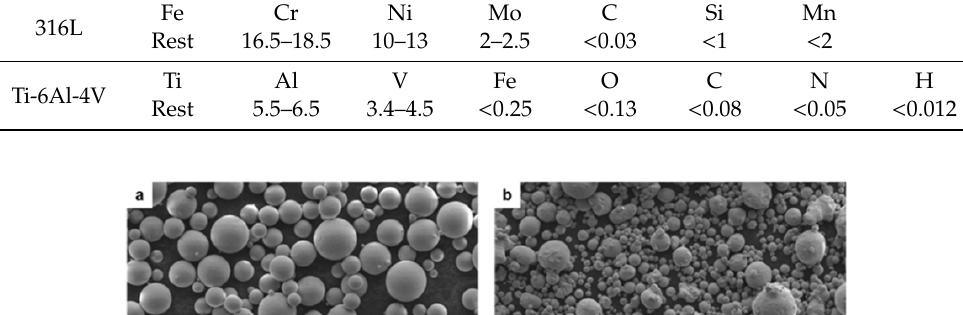
Table 1. Nominal chemical composition of the 316L and Ti6Al4V powders in weight-%.